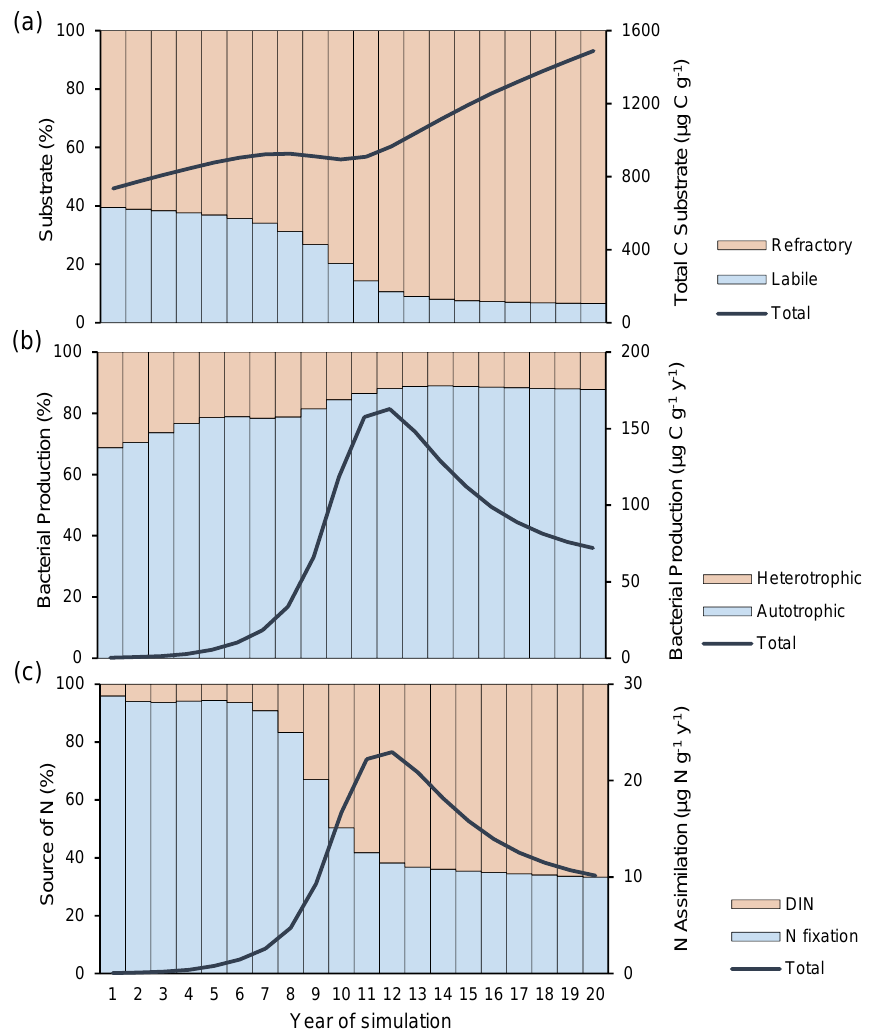
Figure 13. Evolution of (a) substrate dynamics, (b) bacterial production and (c) nitrogen (N) assimilation of model output from the first 20 years of soil formation at the Damma Glacier,